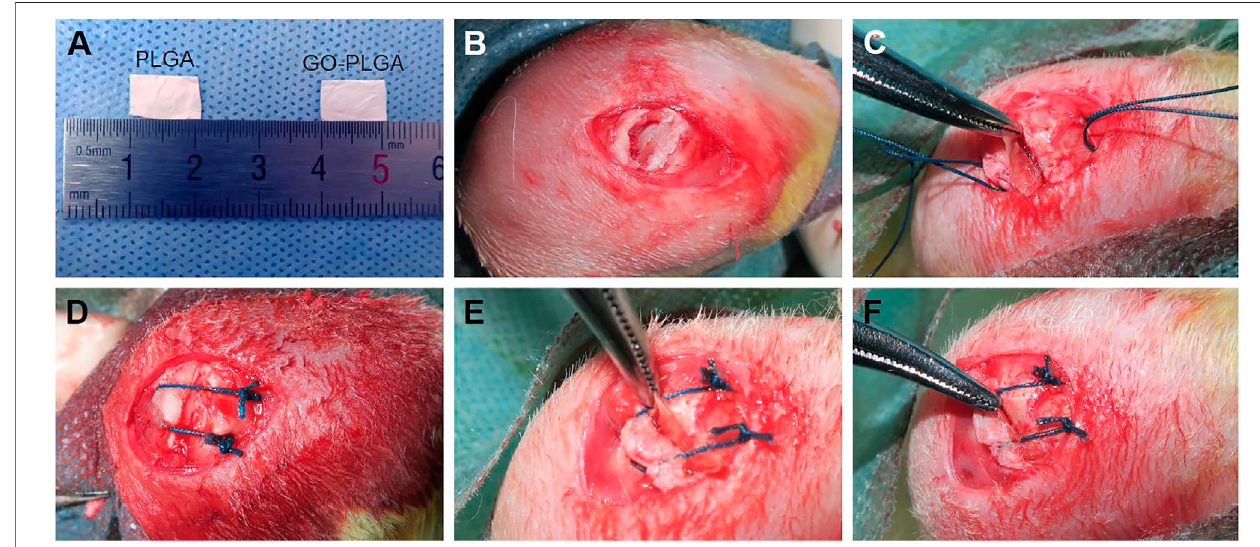
FIGURE 5 | (A) General view of PLGAand PLGA-GO membranes and (B – F) surgical procedure of interposition of PLGAand PLGA-GO membranes in the rabbit supraspinatus tendon repair model. Reproduced from Su et al. (2019) with permission from Copyright 2019 Dove Medical Press